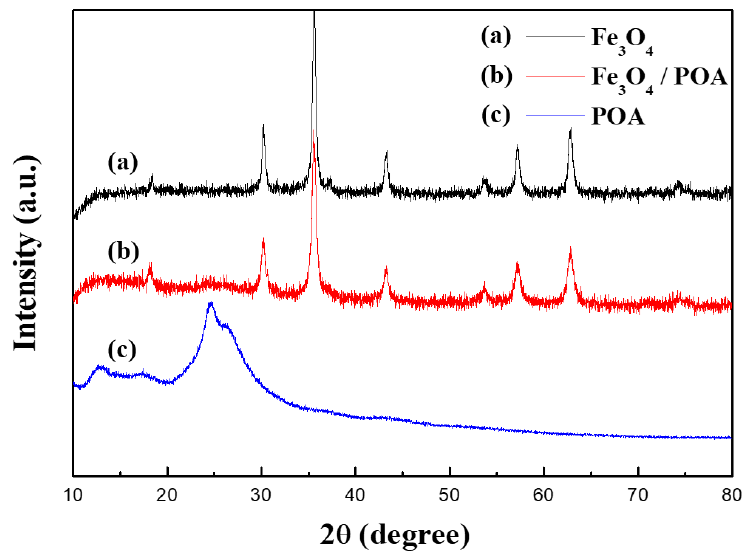
Figure 4. XRD data of ( a ) pure Fe 3 O 4 , ( b ) the Fe 3 O 4 /POA composite particles, and ( c ) the POA particles.